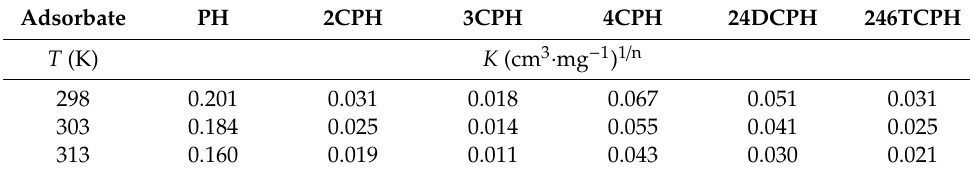
Table 6. Adsorption equilibrium constants for phenol (PH), 2-chlorophenol (2CPH), 3-chlorophenol (3PH), 4-chlorophenol (4CPH), 2-, 4-dichlorophenol (24DCPH) and 2-, 4-, 6-trichlorophenol (246TCPH) on HDTMA / HAL adsorbent calculated by Equation (17) determined with the PD ILC method.